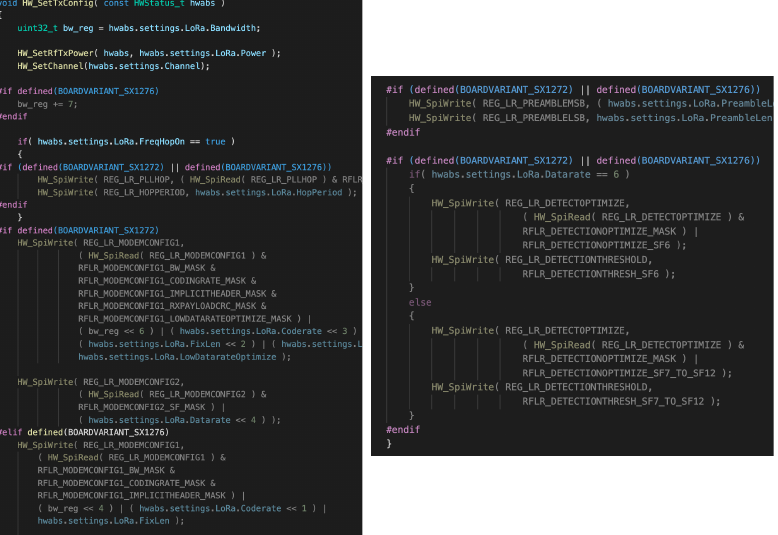
Figure 4. The implementation of the HW_setTxConfig